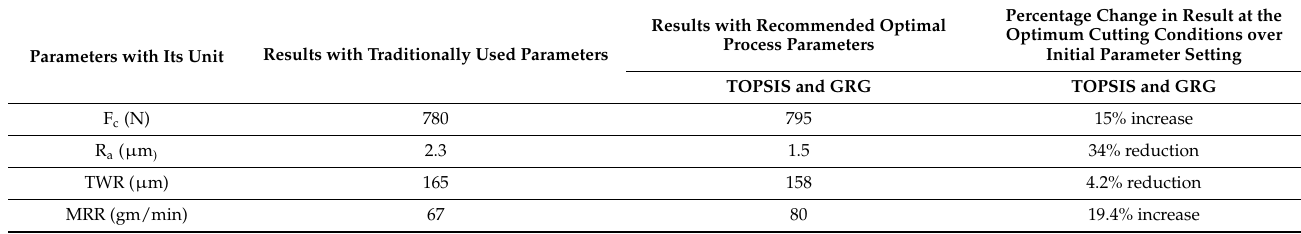
Table 11. Percent changes of the optimized parameter with initial parameter setting.